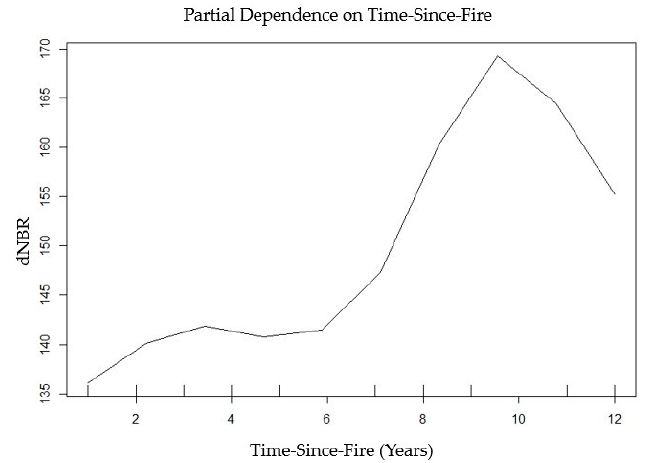
Figure 12. Partial dependence plot showing the influence of time-since-fire.